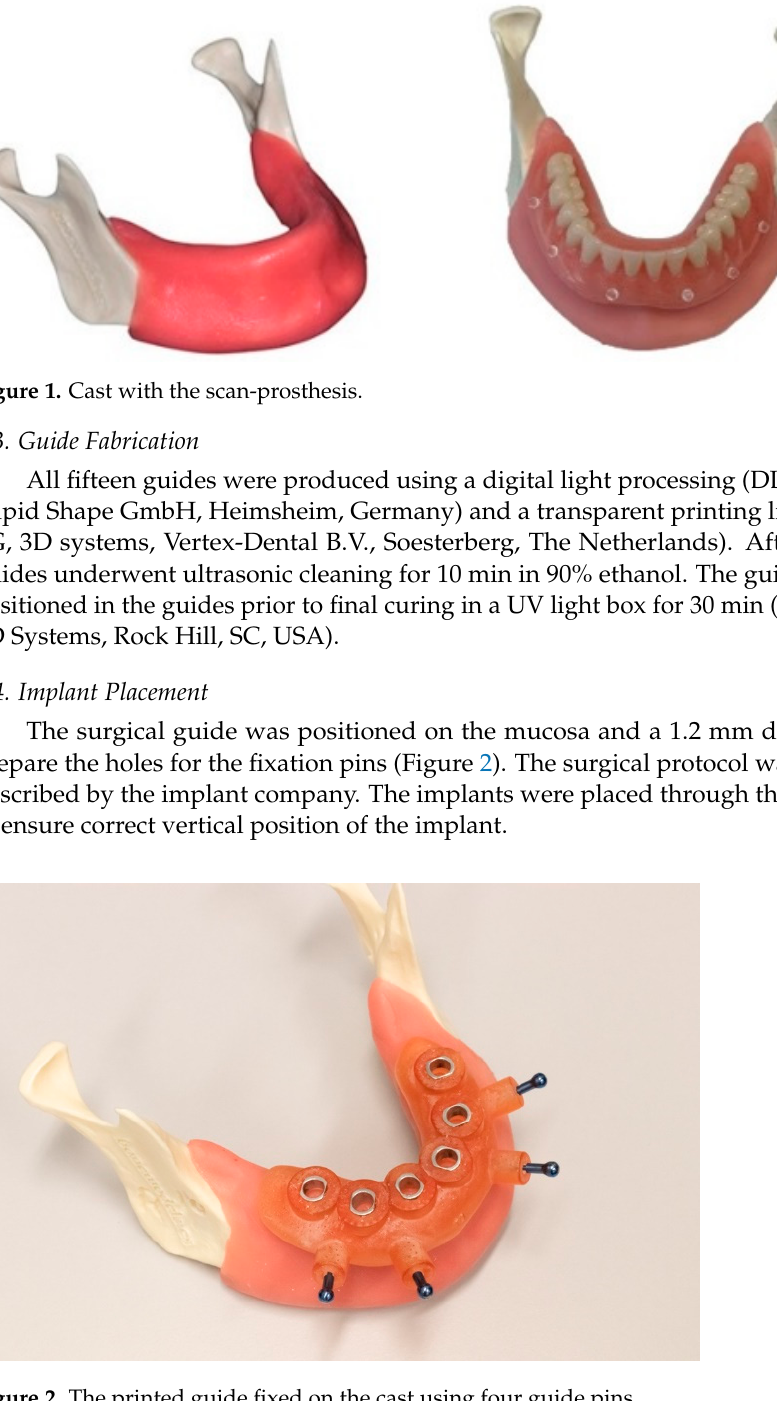
Figure 2. The printed guide fixed on the cast using four guide pins.